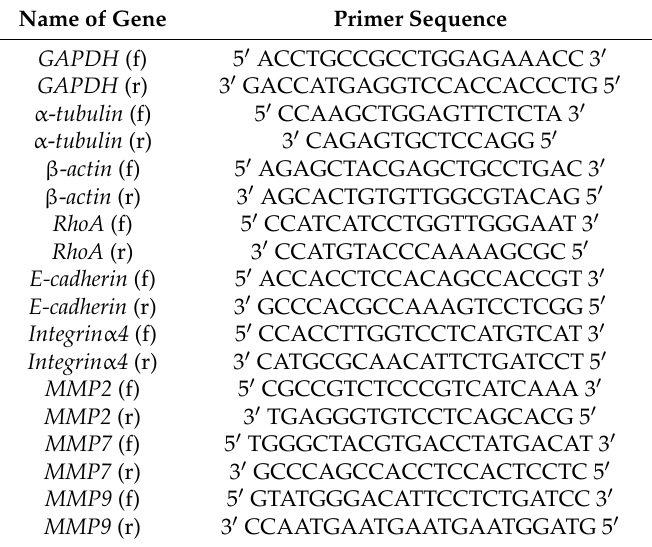
Table 1. Primer pairs for genes used in quantitative real-time PCR. Name of